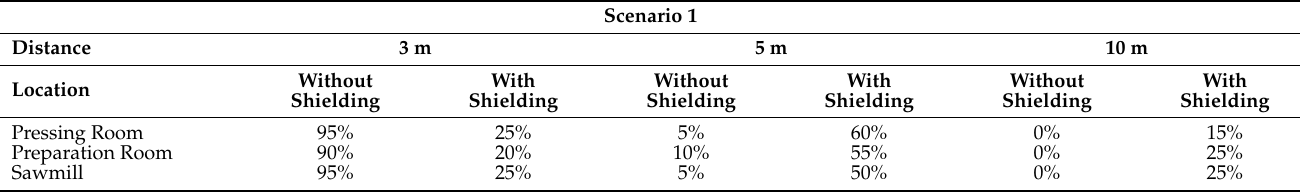
Table 2. Scenario 1: Success rate of determining distance from